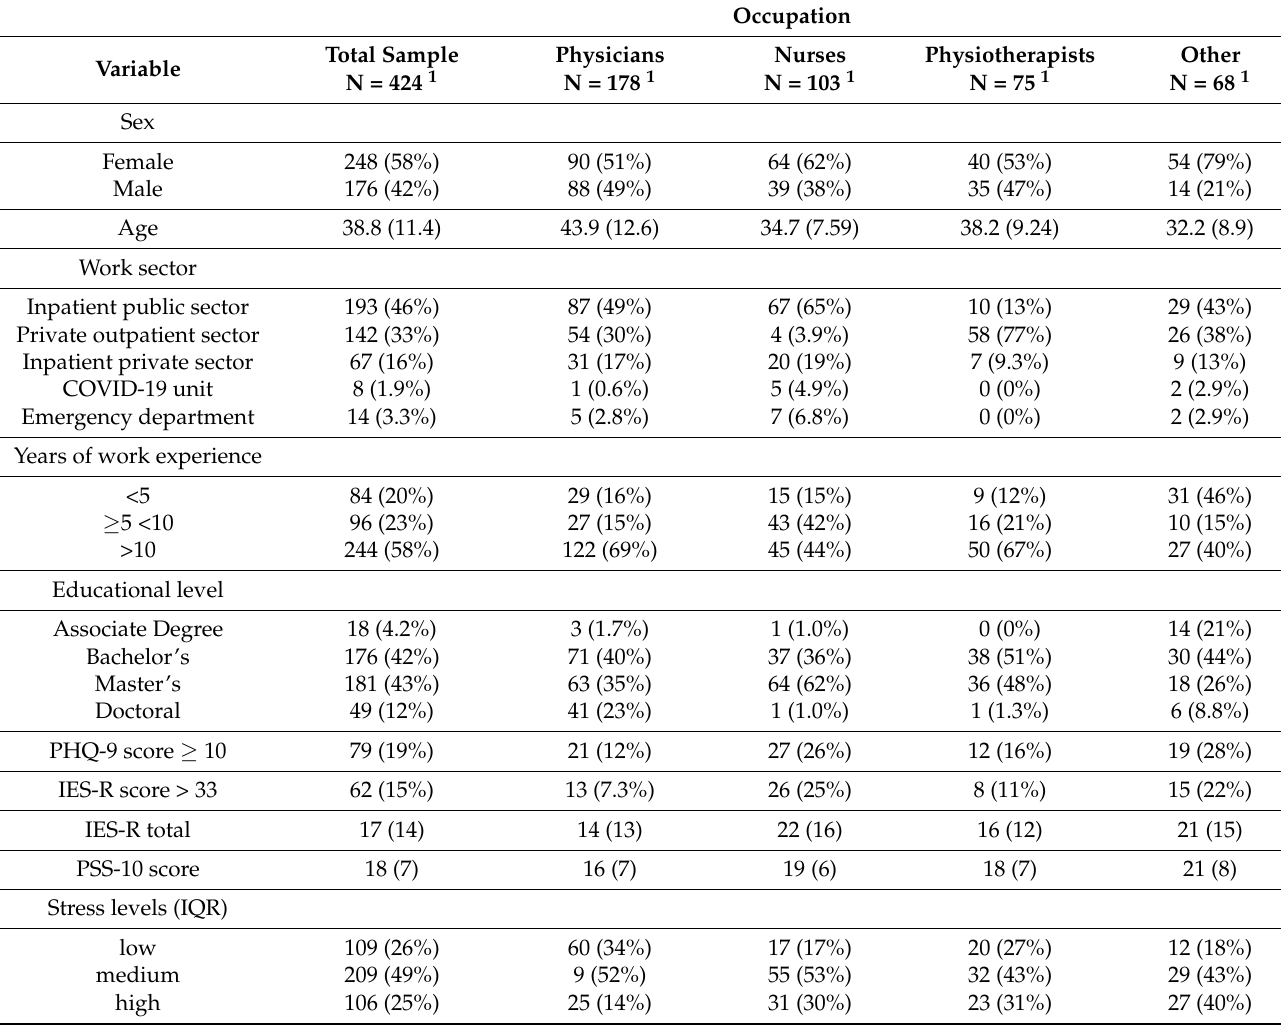
Table 1. Characteristics of study